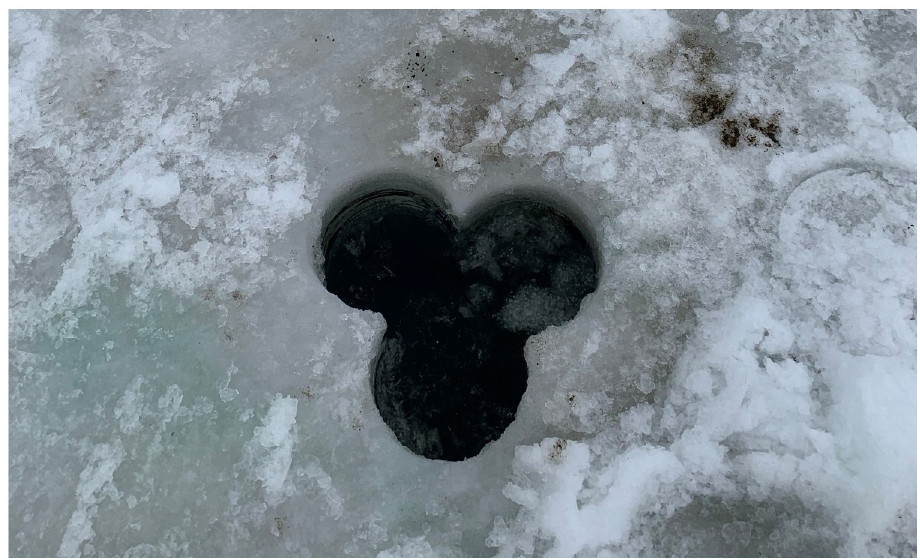
Fig 2. Holes for through-ice sampling. Image of the hole pattern drilled with ice auger to create large enough holes to accommodate D-net and scooping motions used in sediment sample collection.